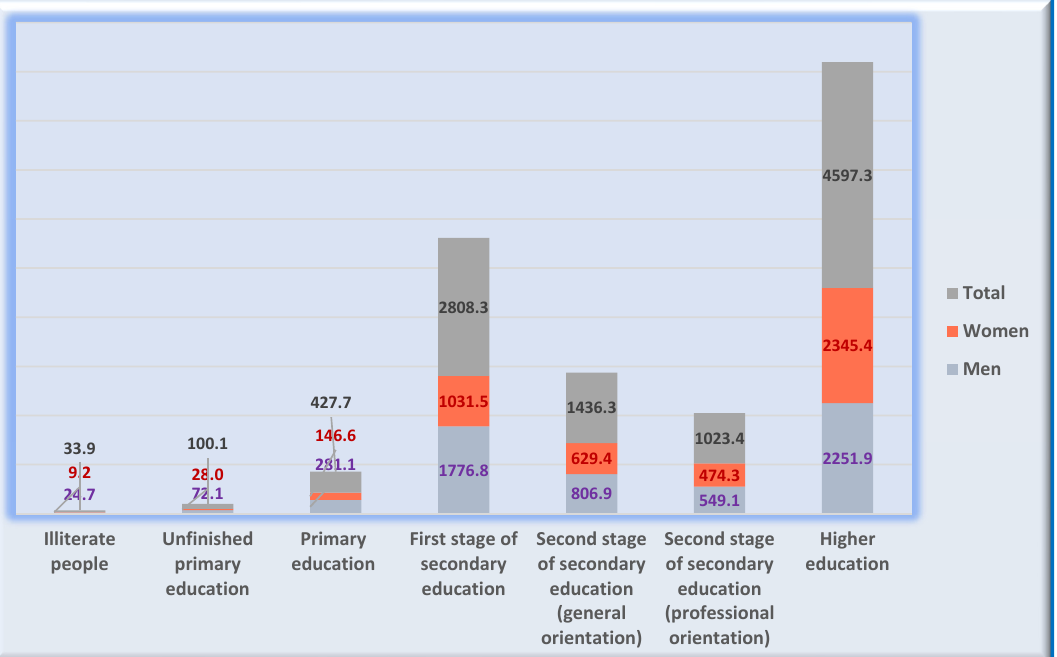
Figure 9. Employed unmarried persons by sex and educational level attained (in thousands). Source: Authors with data corresponding to the fourth quarter of 2020 provided by the Statistics National Institute ( Instituto Nacional de Estadística ).